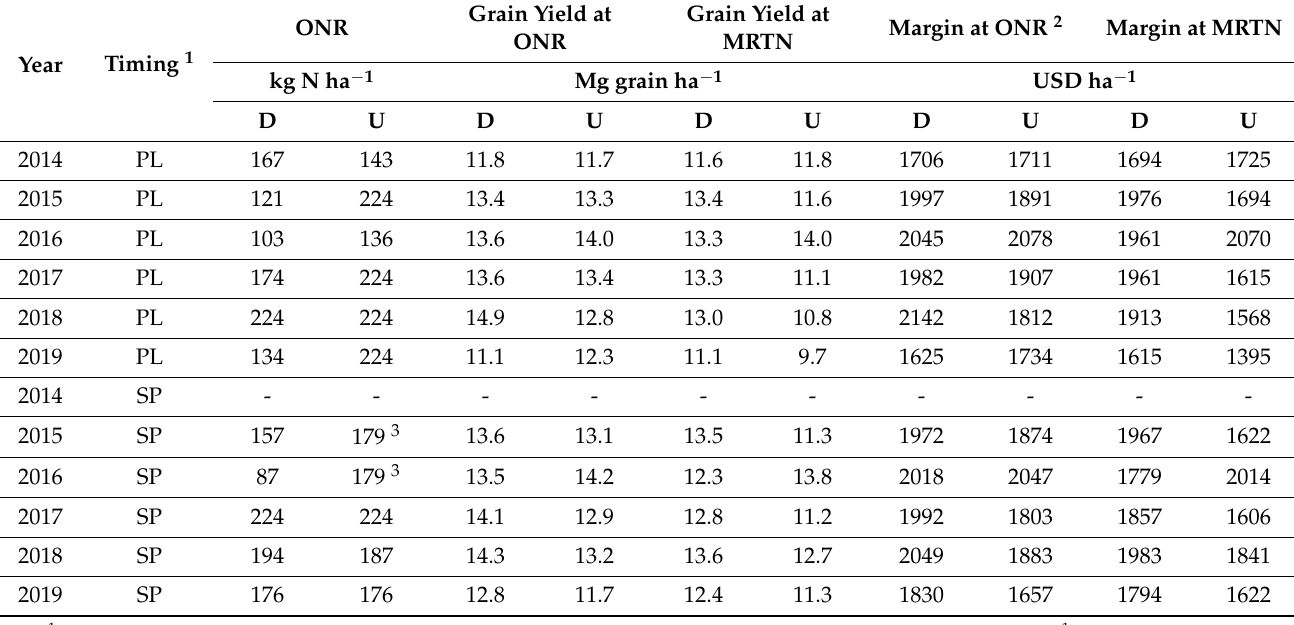
1 At-planting (PL) fertilization was done within 14 days of planting and split (SP) fertilization was 45 kg N ha − 1 at planting and the remainder at V6 to V8 development stage. 2 Profit margin at ONR is the income generated with the estimated yield (USD 157 Mg − 1 grain) at ONR minus the cost of nitrogen (USD 0.88 kg − 1 N) at ONR. Similar calculations were used for the MRTN rate (145 kg N ha − 1 ). Profit margins for SP was reduced by USD 25 ha − 1 to account for the additional cost to apply nitrogen in season. 3 Highest nitrogen rate applied for SP in 2015 and